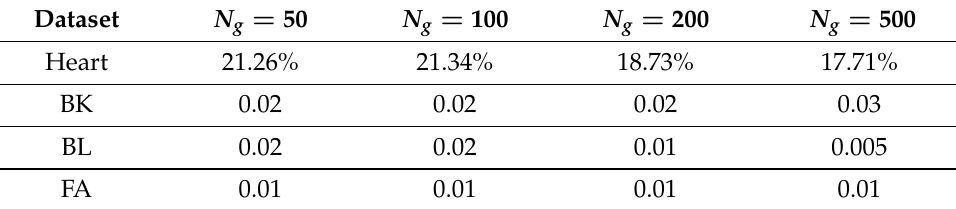
Table 6. Experiments with the number of chromosomes for the algorithm of Section 2.2.